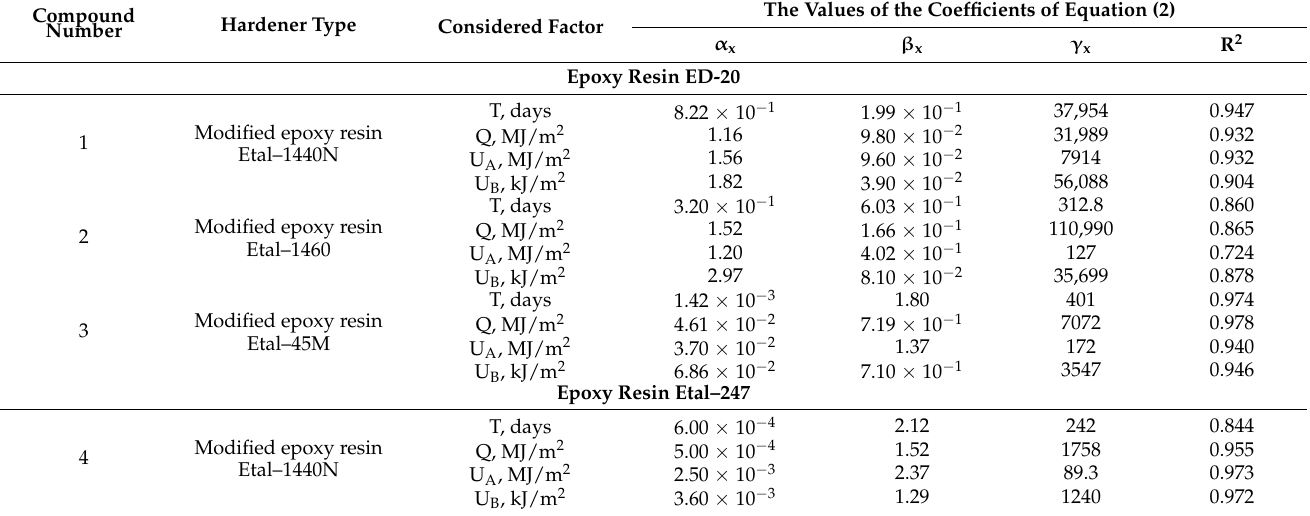
Table 3. Values of the coefficients of Equation (2) describing the influence of exposure time ( T ), total solar radiation intensity ( Q ) and A ( U A ) and B ( U B ) on the total color difference of epoxy polymers exposed under full-scale conditions (spectrophotometer).